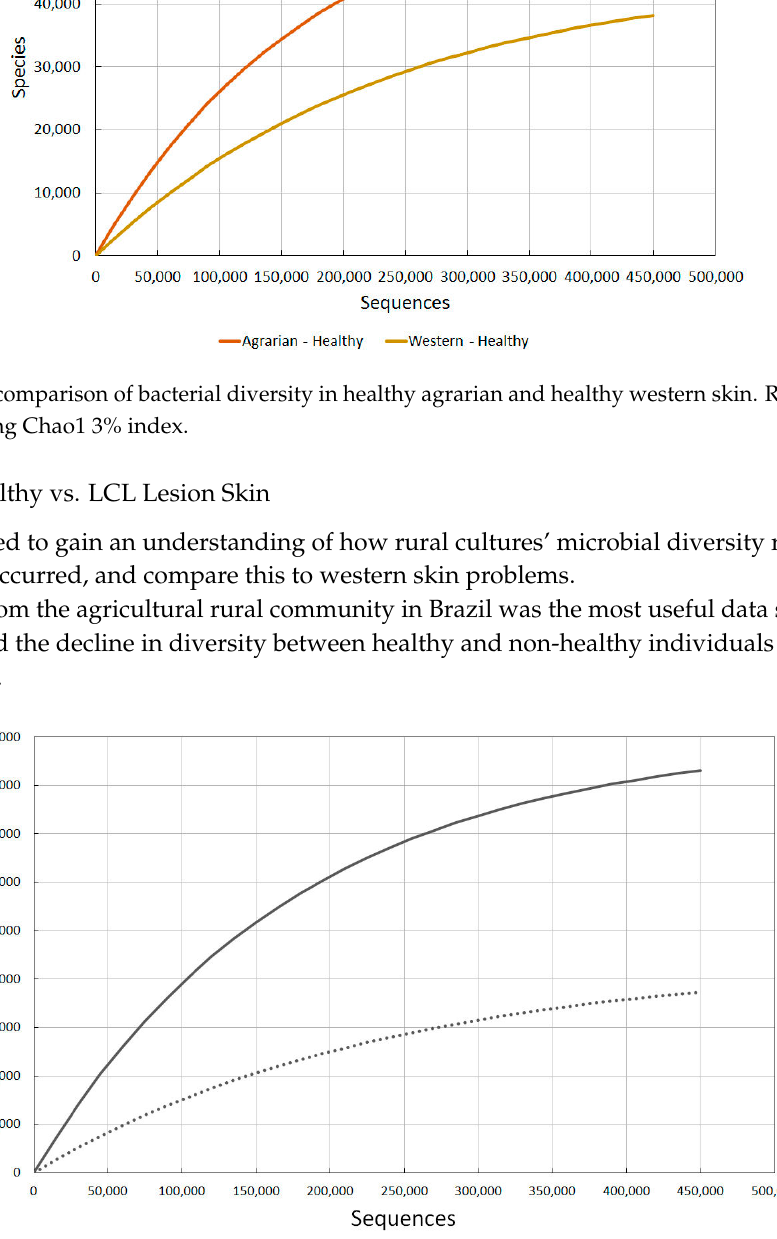
Figure 4. A comparison of bacterial diversity in healthy rural and localised cutaneous leishmaniasis (LCL) lesioned skin. Rarefaction analysis using Chao1 3% index.